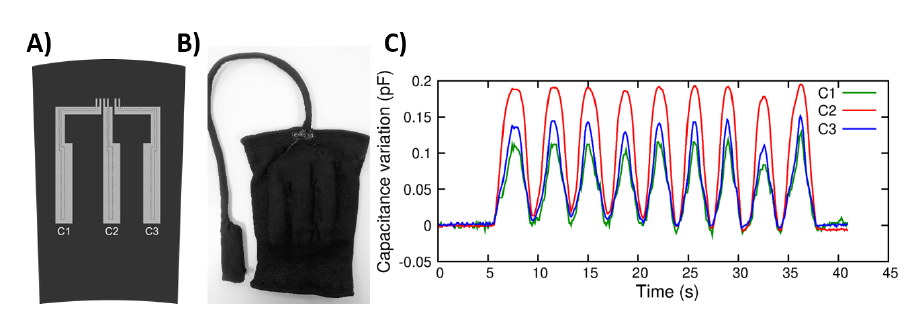
Figure 4. Sensing kneepad integrated into the XoSoft exosuit prototype. ( A ) Schematics of the sensorized kneepad with three embedded capacitive strain sensors. ( B ) Kneepad with sensors covered by textile patches and with coaxial cables embedded in an elastic sleeve. ( C ) Raw soft sensor outputs during normal walking